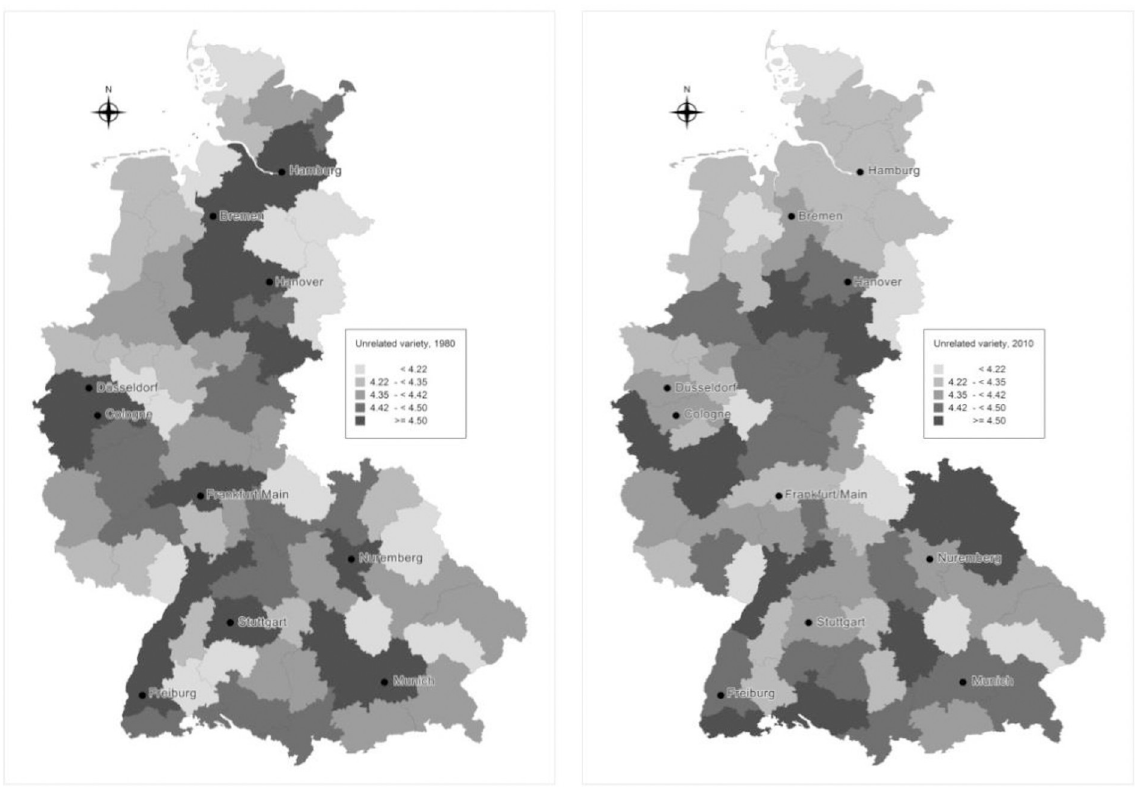
Fig 6. Unrelated variety in 1976 (on the left) and 2010 (on the right). Source: Authors.